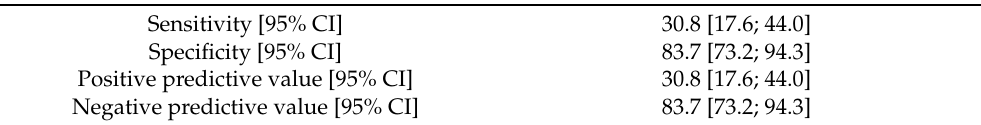
Table 2. Characteristics of the Odysight ® test for exudative recurrence screening in total analyzable population ( n = 47 patients).